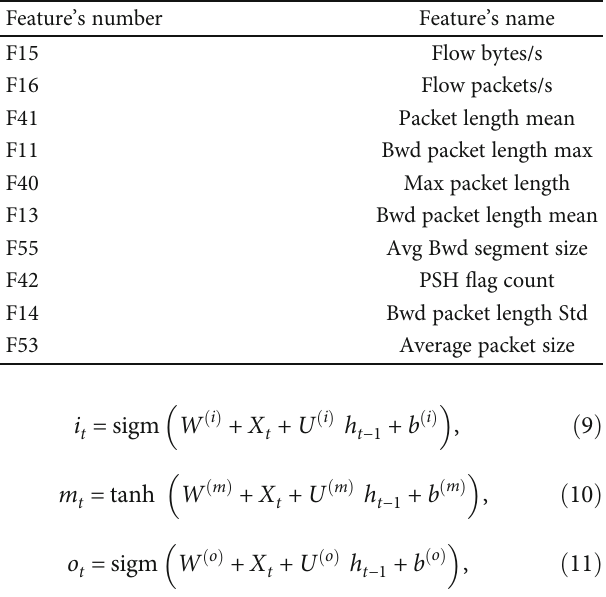
Table 4: Top ranked features of CIC-ID2017 using information gain method.